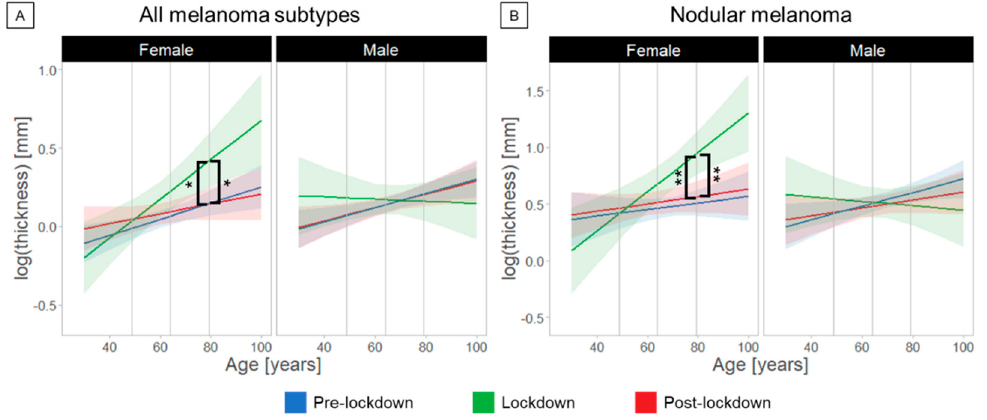
Figure 2. Age- and gender-dependent differences in melanoma diagnosis relative to the COVID-19 lockdown in Switzerland; post-hoc analysis showed increased tumor thickness in older women among all melanoma subtypes ( A ) and especially regarding the nodular melanoma subtype ( B ) during lockdown period. The logarithm of the melanoma thickness is plotted as function of age, gender, and lockdown periods. Asterisks indicate significant differences in the diagnosed melanoma thickness according to post-hoc analyses (* lockdown minus pre-lockdown in older female p = 0.03, * lockdown minus post-lockdown in older female p = 0.048; ** lockdown minus pre-lockdown in older female p = 0.0021, ** lockdown minus post-lockdown in older female p = 0.008). Note: Number of patients